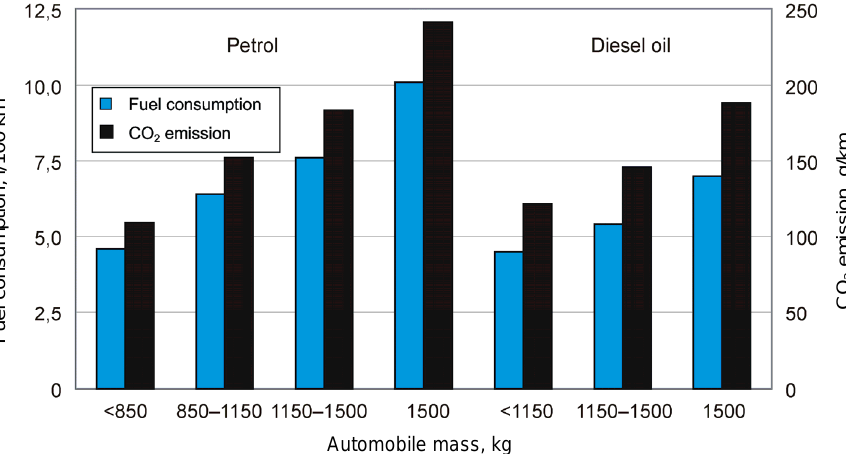
Fig 5. The relationship between average fuel consumption and CO 2 emission of an automobile and its mass